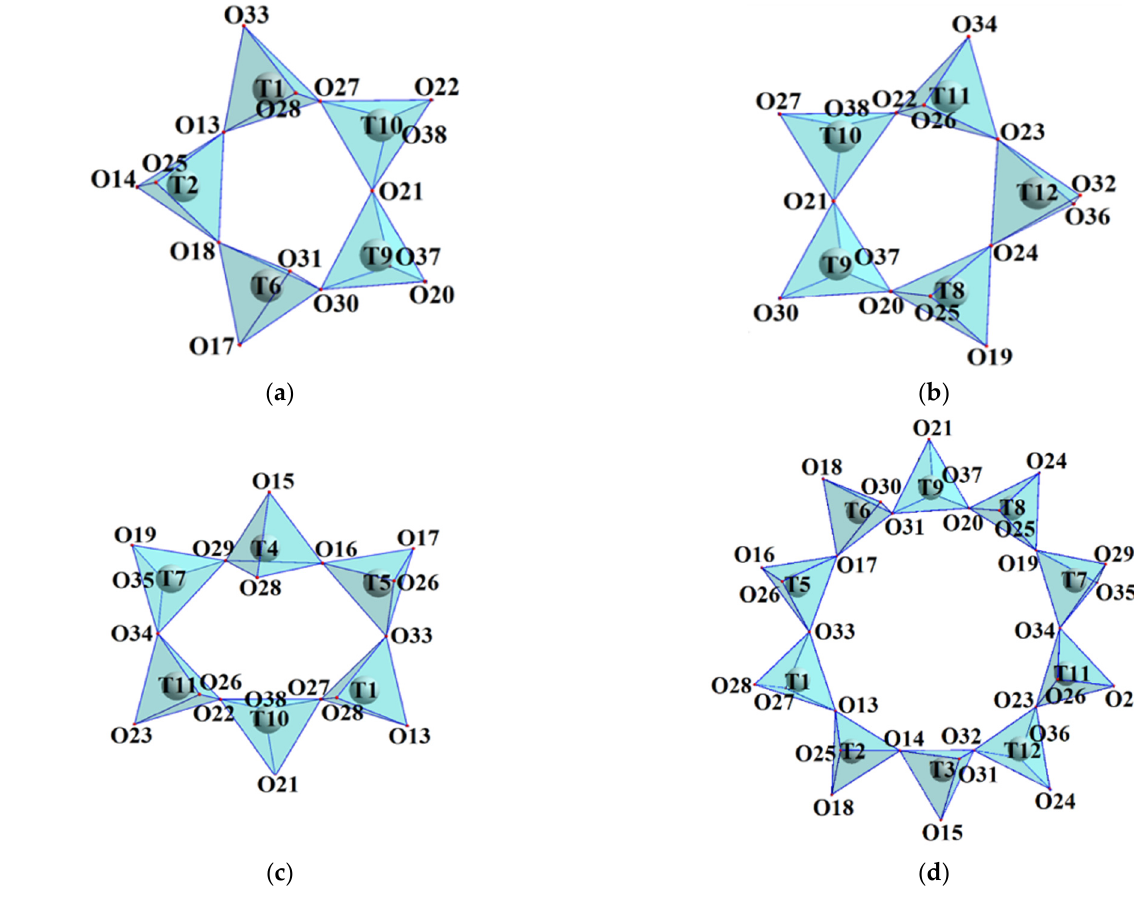
Figure 1. MFI-type zeolite tetrahedra rings (orthorhombic symmetry): 5-membered ( a ), 5-membered ( b ), 6-membered ( c ), 10-membered ( d ). The primary structure of HZSM zeolites (Adapted from [33]).